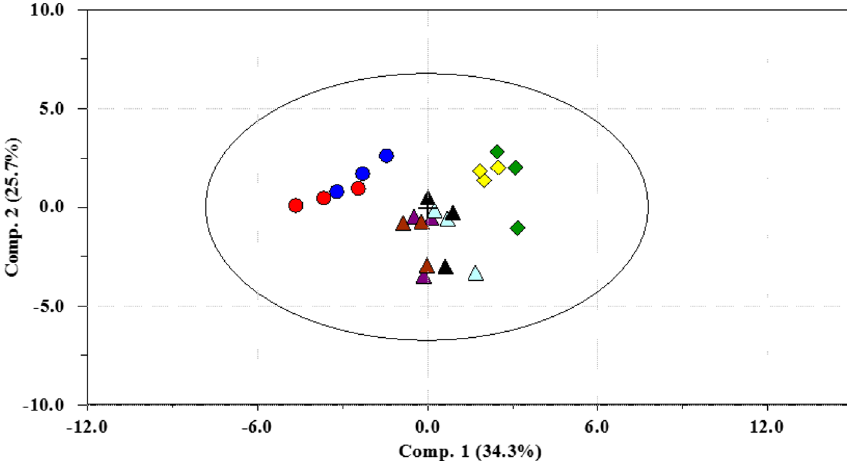
Fig. 3 PCA score plot for phys- icochemical characteristics of water samples